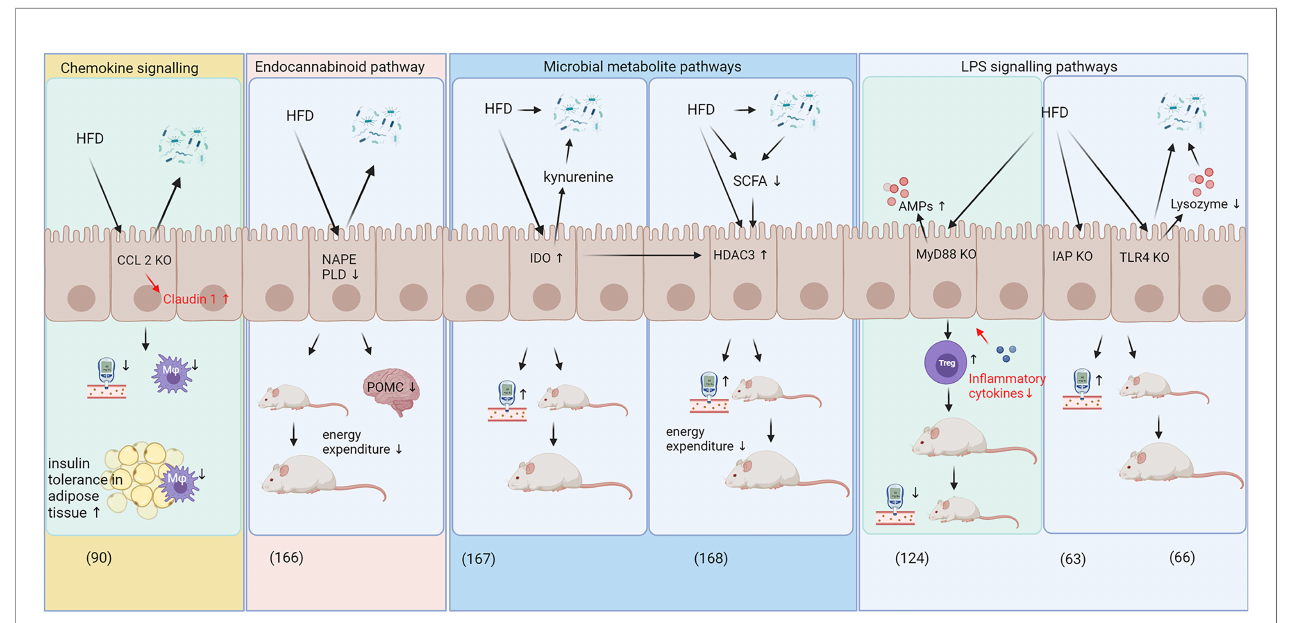
FIGURE 2 | Speci fi c and diverse roles of IECs in HFD-induced metabolic disease. The roles of intestinal epithelial cells (IECs) in body weight gain and glucose homeostasis can be categorized into immune crosstalk/chemokine signaling (90), pathways involving the endocannabinoid system (166), pathways involving microbial metabolites (167, 168) and signaling pathways related to LPS signaling (63, 66, 124). While most pathways exerted adverse effects on glucose metabolism and weight gain in response to HFD feeding, IEC speci fi c knockout of CCL2 and MyD88 decreased body weight gain and improved glucose metabolism during high-fat diet feeding (90, 124). CCL2 and MyD88 knockout improved intestinal barrier function by increasing claudin 1 levels and decreased expression of in fl ammatory cytokines, respectively (highlighted in red). AMPs, antimicrobial peptides; CCL2, C-C motif chemokine ligand 2; HDAC3, histone deacetylase 3; HFD, high fat diet; IAP, intestinal alkaline phosphatase; IDO, Indolamine 2;3-dioxygenase; IEC, intestinal epithelial cells; KO, knockout; LPS, lipopolysaccharides; M j , macrophages; MyD88, myeloid differentiation primary response gene 88; NAPE PLD, N-acylphosphatidylethanolamine phospholipase D; POMC, pro-opiomelanocortin; SCFA, short chain fatty acids; TLR4, toll-like receptor 4; Treg, regulatory T